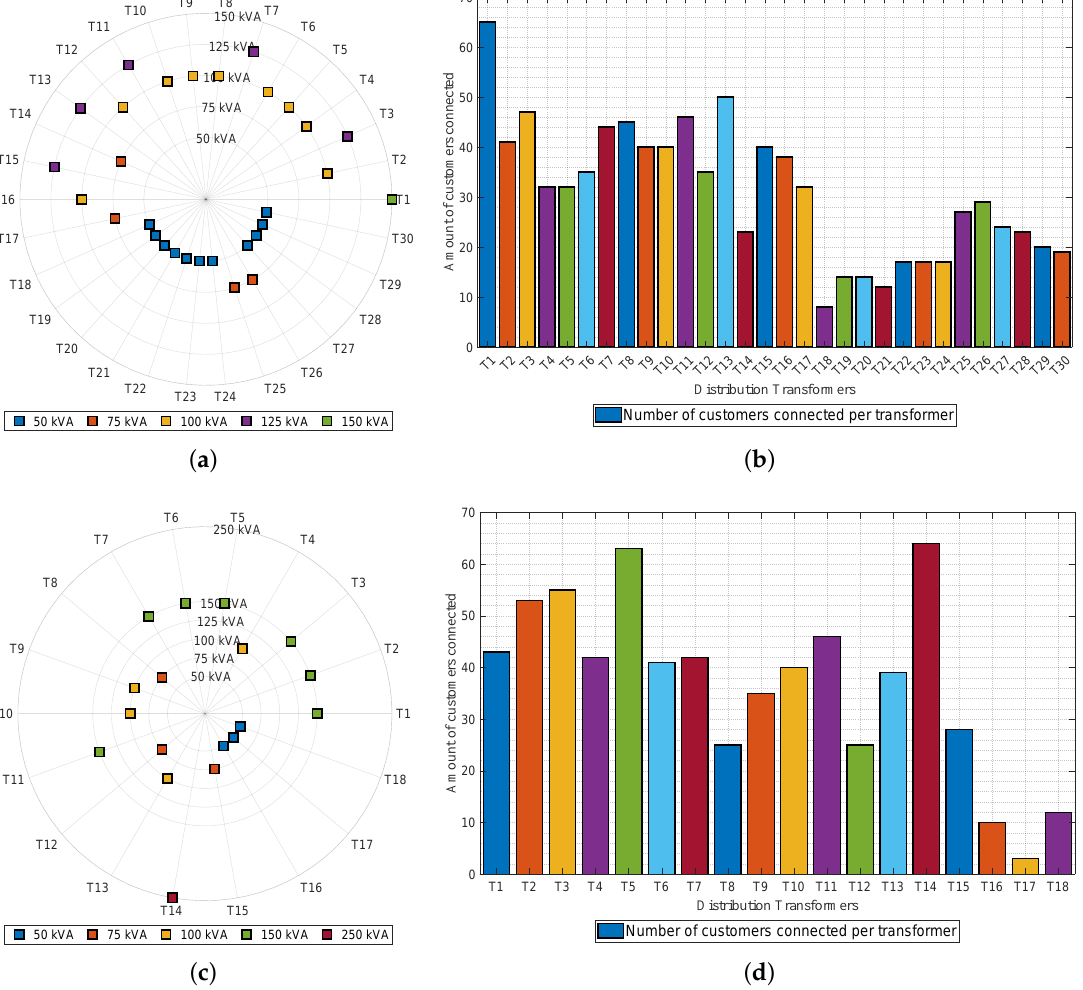
Figure 5. A set of four subfigures: ( a ) Case study 1: kVA distribution transformers, ( b ) case study 1: Number of end users connected to distribution transformers, ( c ) case study 2: kVA distribution transformer and ( d ) case study 2: Number of end users connected to distribution